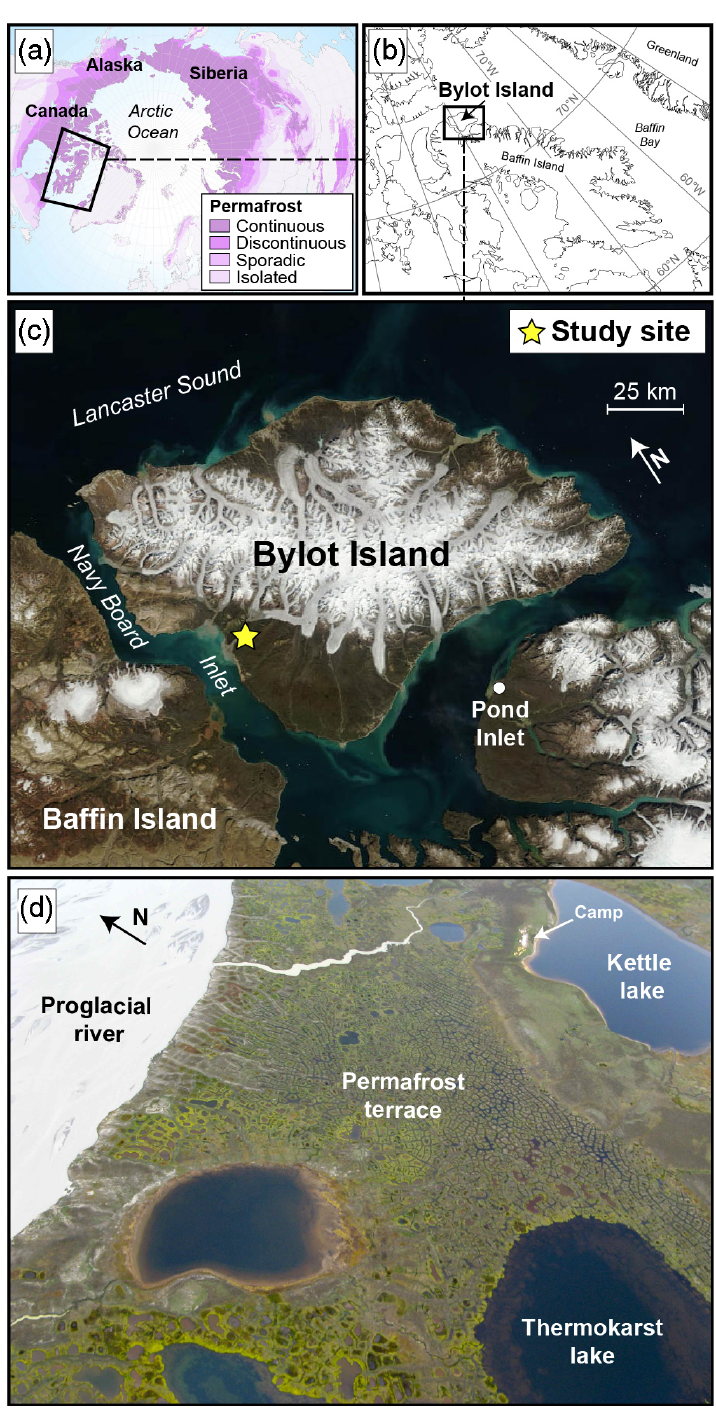
Figure 1. Location of the study site in the continuous permafrost zone of the Eastern Canadian Arctic (a) , north of Baffin Island (b) , within one of the several glacier valleys of Bylot Island, Nunavut (c) . The studied valley contains numerous aquatic systems of different sizes (d) . Source of the permafrost map (a) : Brown et al. (1998). Satellite photo (c) : Terra-MODIS, 22 July